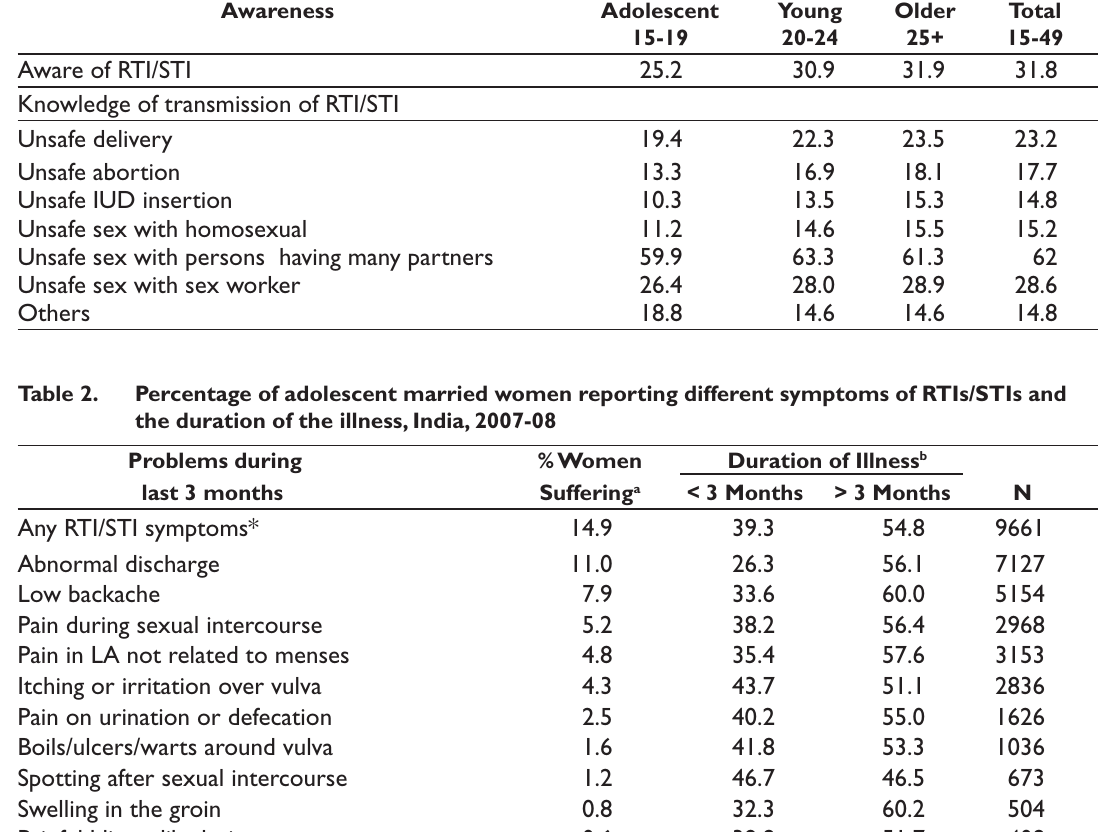
infection is also found to be associated with